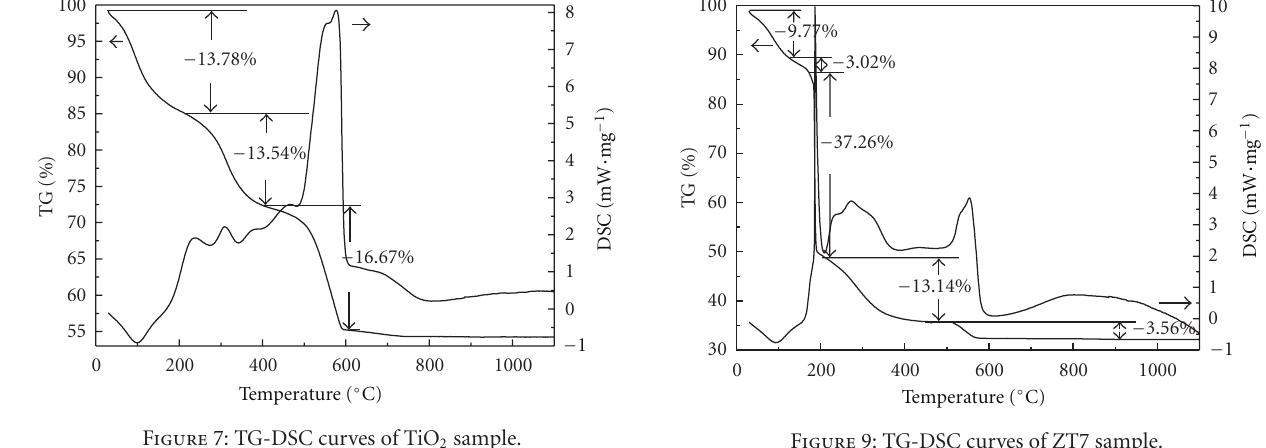
Figure 9: TG-DSC curves of ZT7 sample.